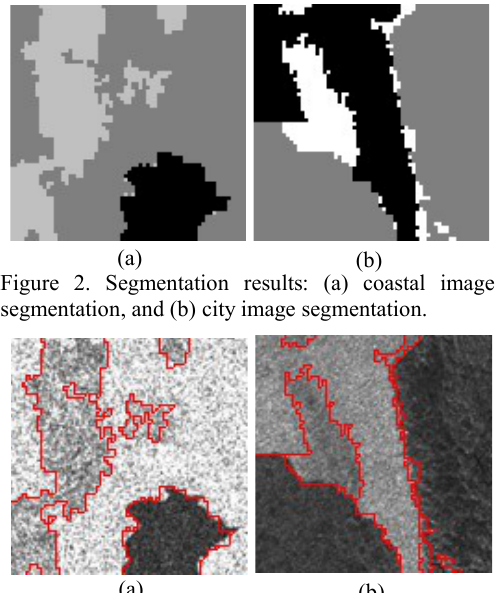
Figure 3. Visual evaluation: (a)- (b) overlaying the outlines on the original images